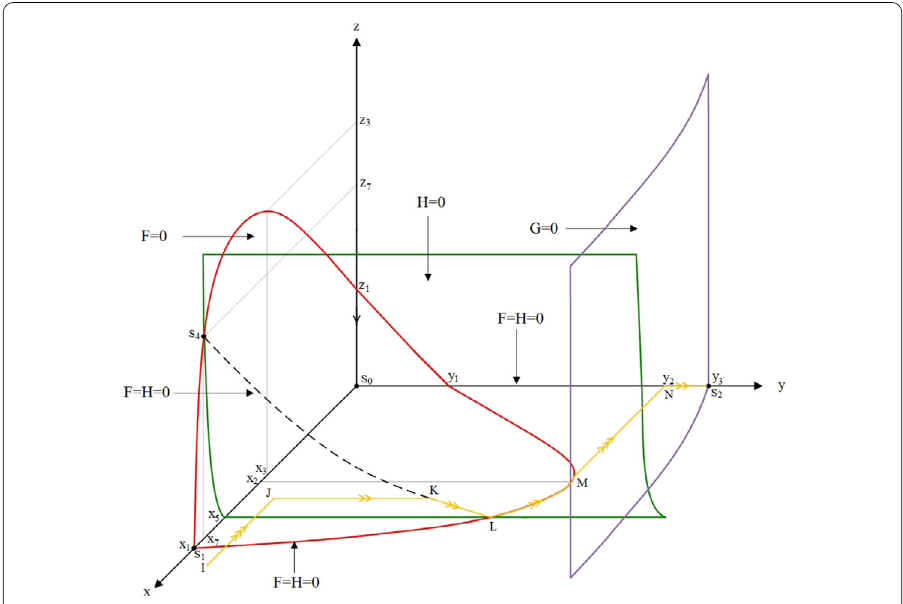
Figure 5 Shapes and relative positions of the manifolds where the parametric values of system of Eqs. (4)–(6) satisfy the conditions in Theorem